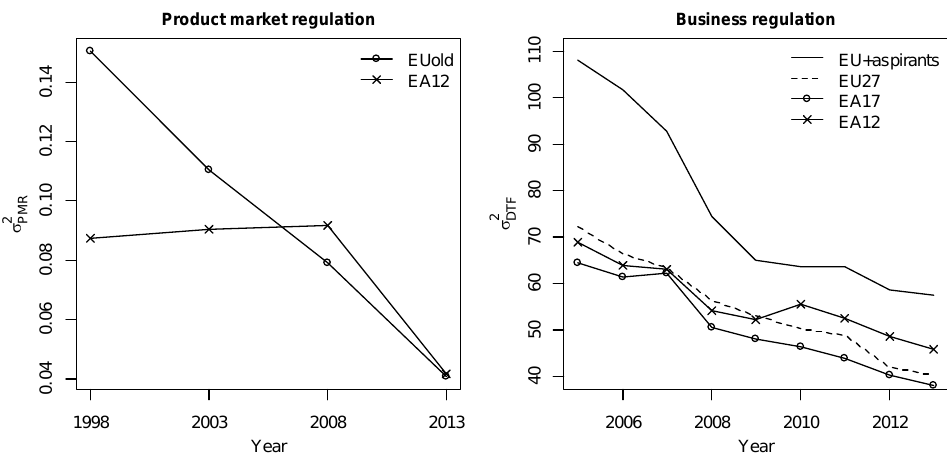
Figure 7 : σ -convergence in product market and business regulation